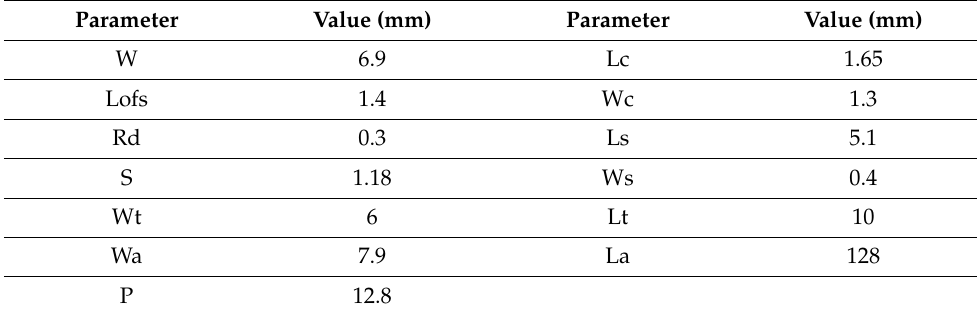
Table 1. Parameters of the periodic SIW